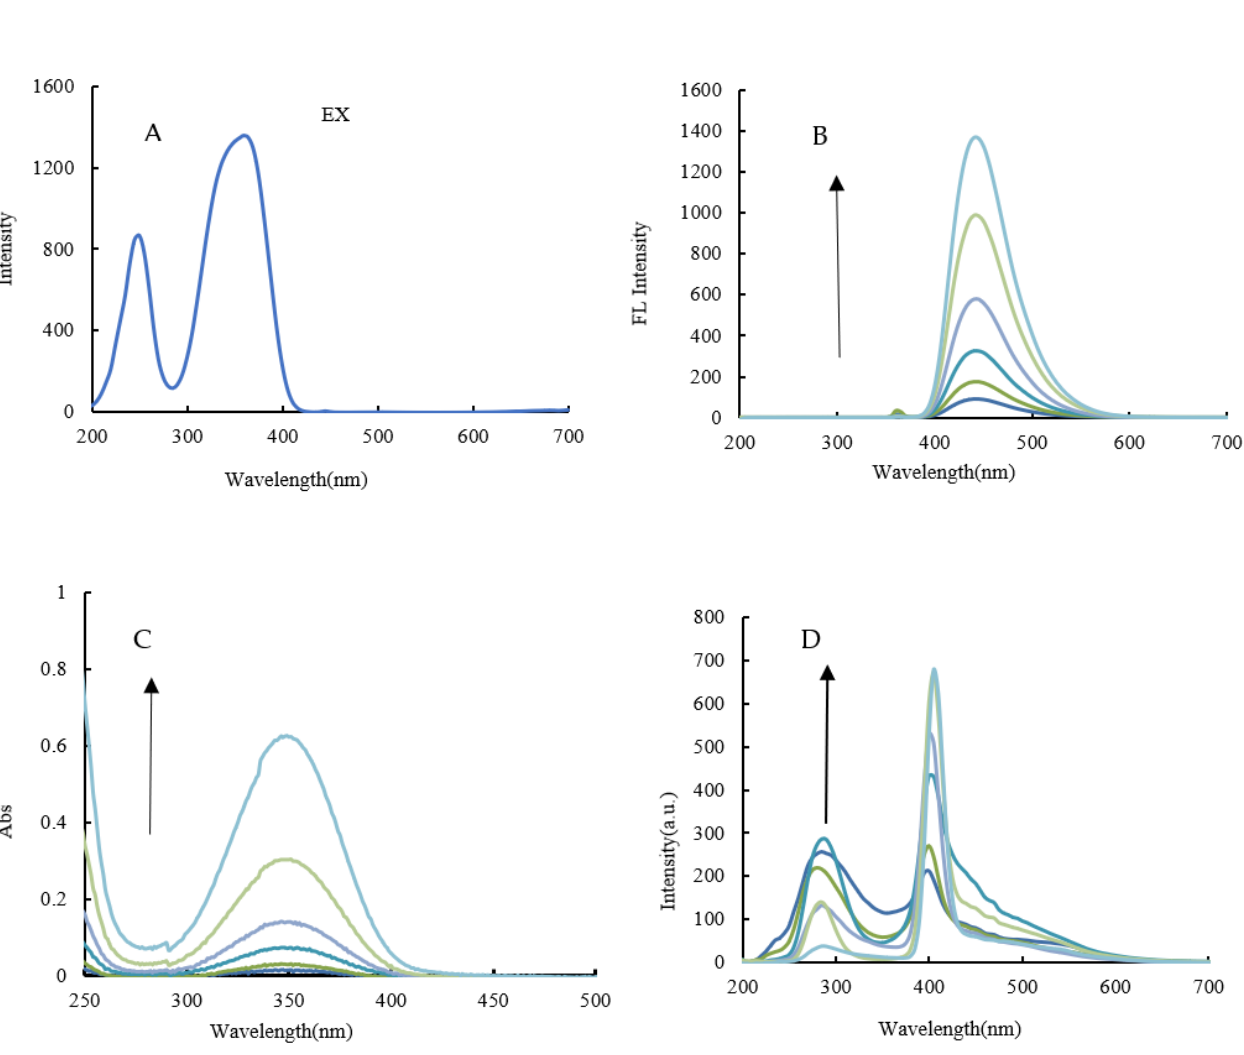
Figure 4. Excitation ( A ), fluorescence ( B ), Abs ( C ), and RRS ( D ) spectra of CD N . A: excitation spectra of CD N ; B: emission spectra of CD N , (2.625, 5.25, 10.5, 21, 42, 84) µ g/mL CD N ; C: Abs spectra of CD N , (26.25, 52.5, 105, 210, 420, 840) µ g/mL CD N ; D: RRS spectra of CD N , (2.625, 5.25, 10.5, 21, 42, 84) µ g/mL CD N .